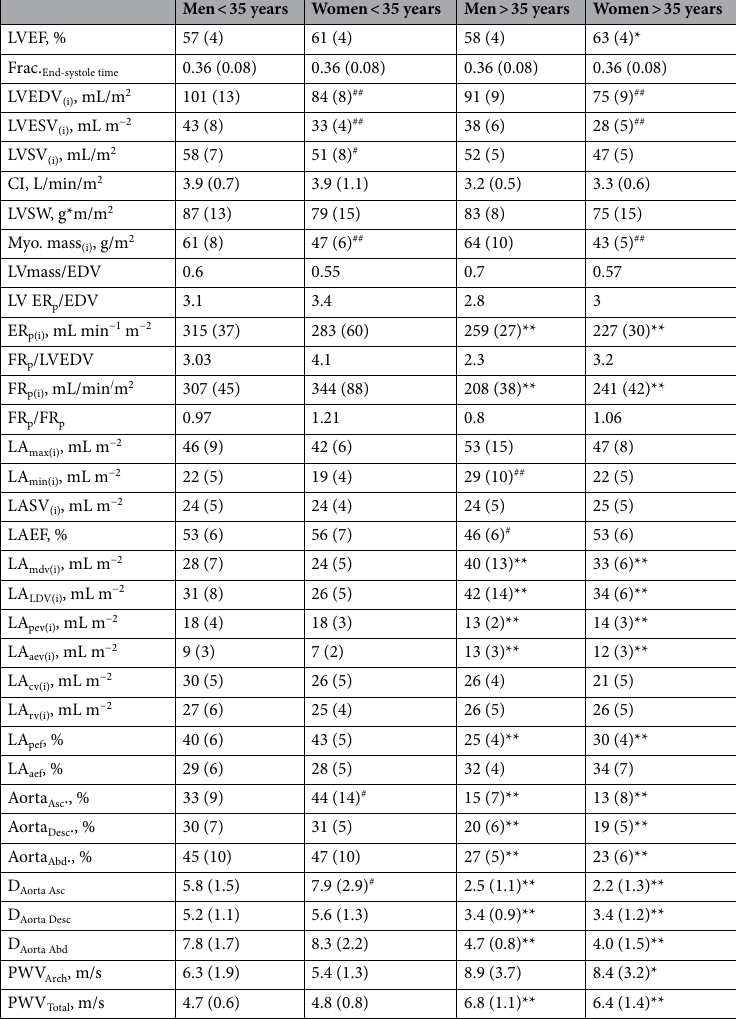
Table 2. Left ventricle and left atrial variables as determined from CMR time-volume curves in 36 healthy young and 16 healthy middle-aged subjects. * p < 0.05 and ** p < 0.01 vs. young of same gender; # p < 0.05 and ## p < 0.01 vs. different gender of similar